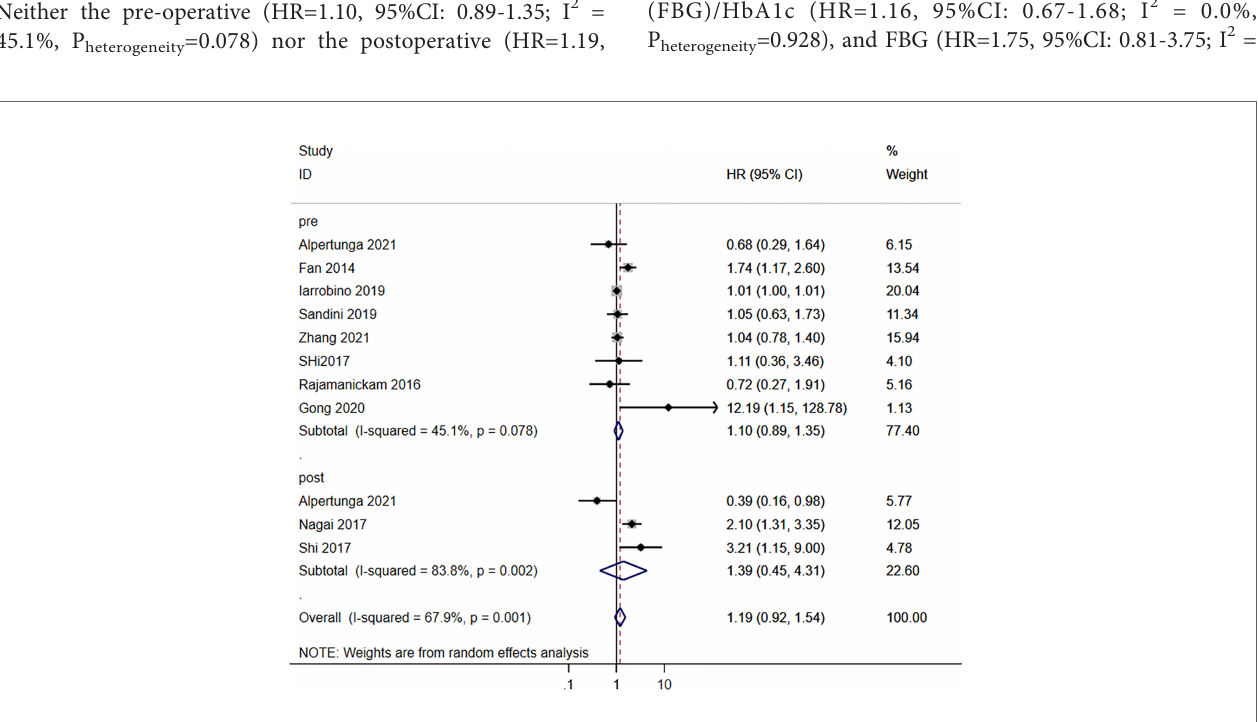
( Supplementary Table S1 ). The case series was deemed of good quality ( Supplementary Table S2 ).